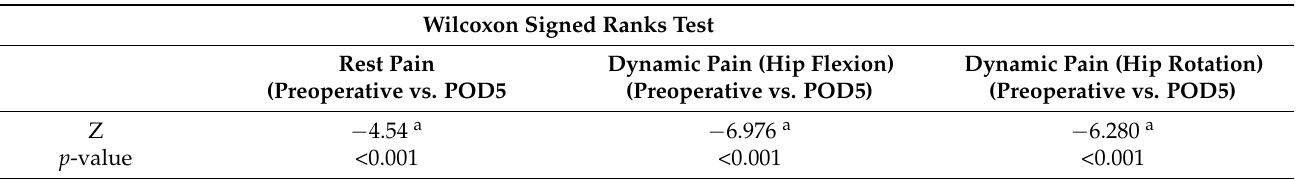
Table A2. The non-parametric test to analyse the median composite pain scores at rest/on hip flexion 80 ◦ /gentle hip rotation before procedure and on post-procedural day